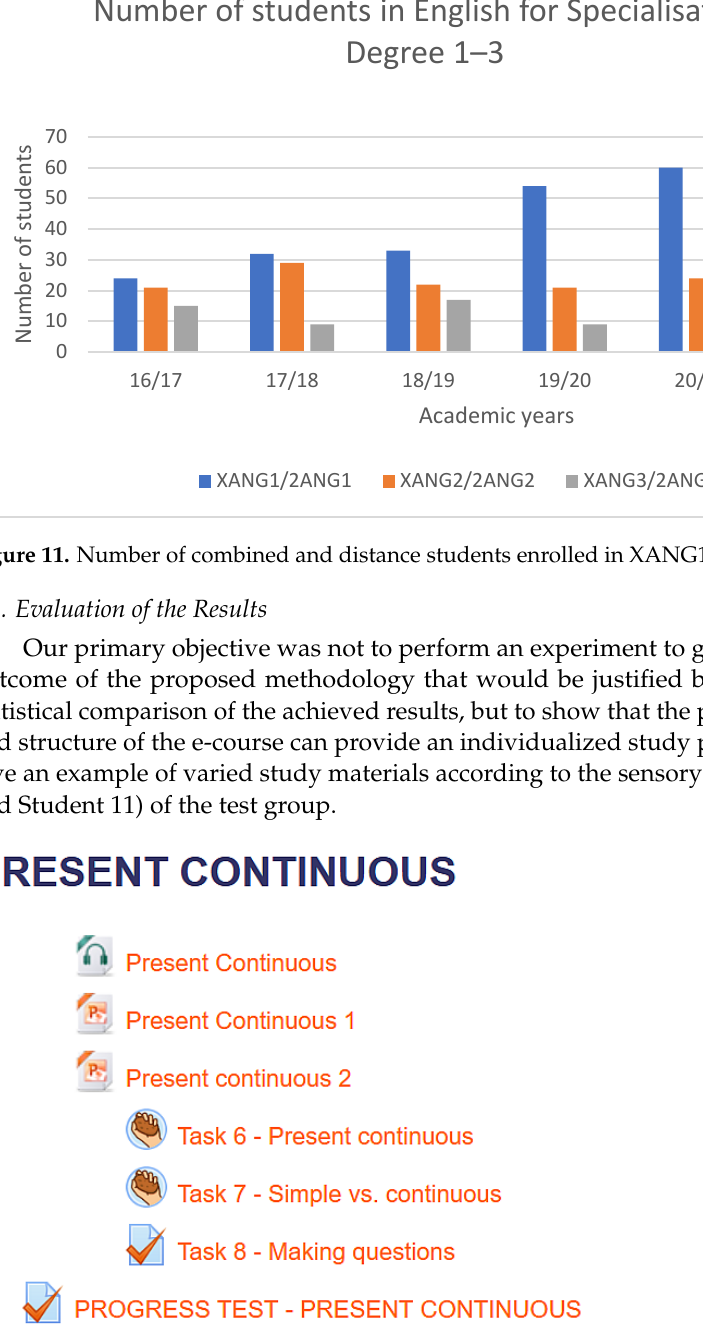
Figure 12. Student11 sensory preferences: V + A.